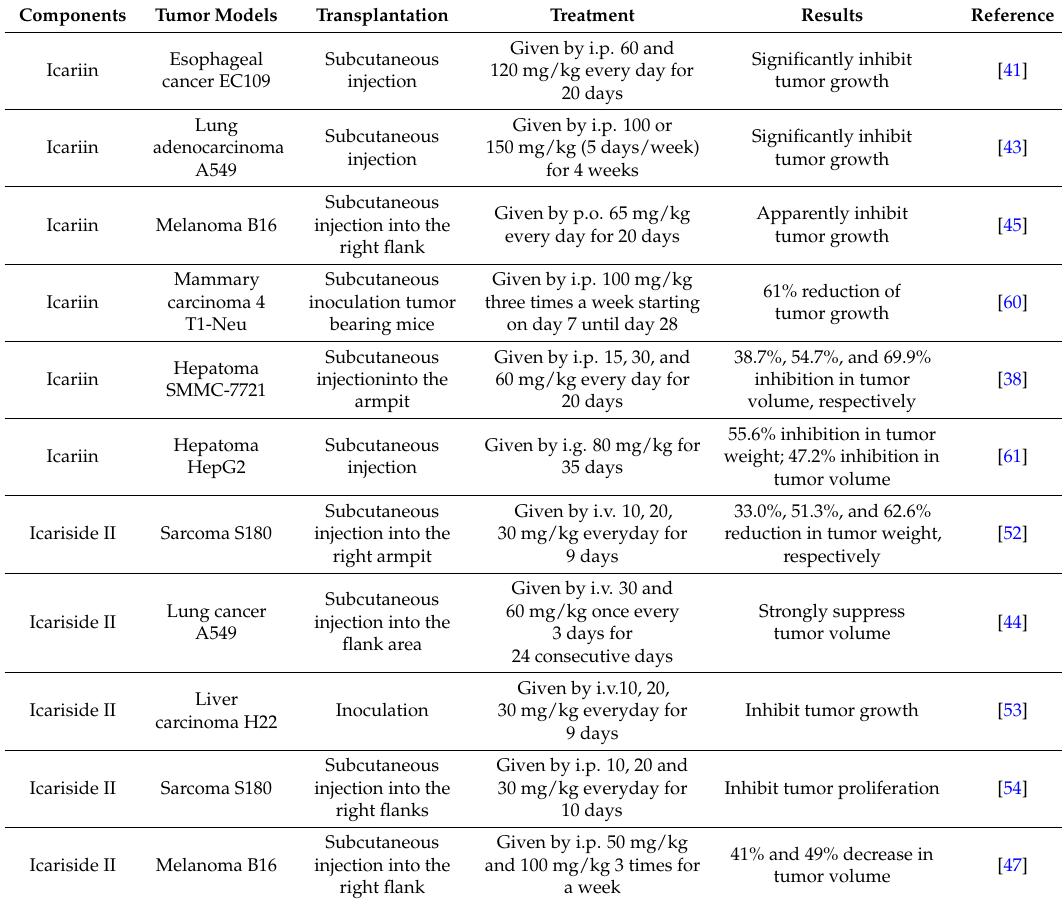
Table 2. In vivo evaluation of icariin and icariside II in mouse tumor